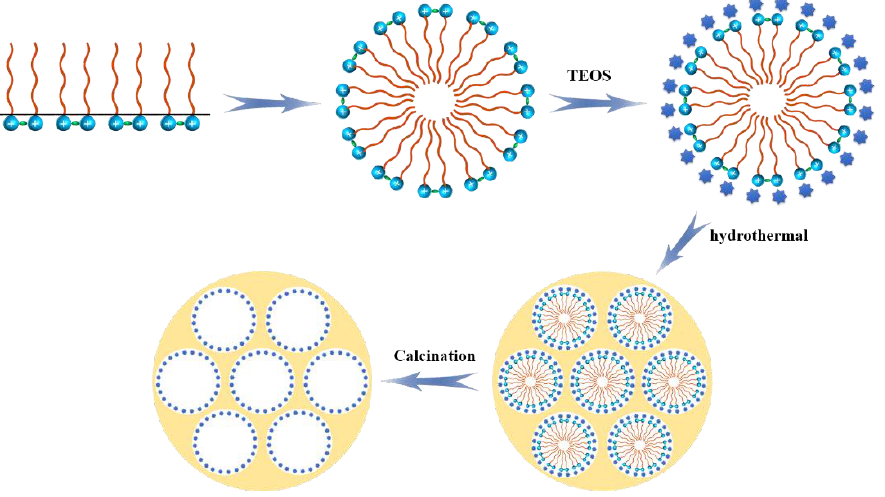
Figure 11. Schematic diagram of preparation of mesoporous molecular sieve with Gemini ionic liquid surfactant as templating agent.